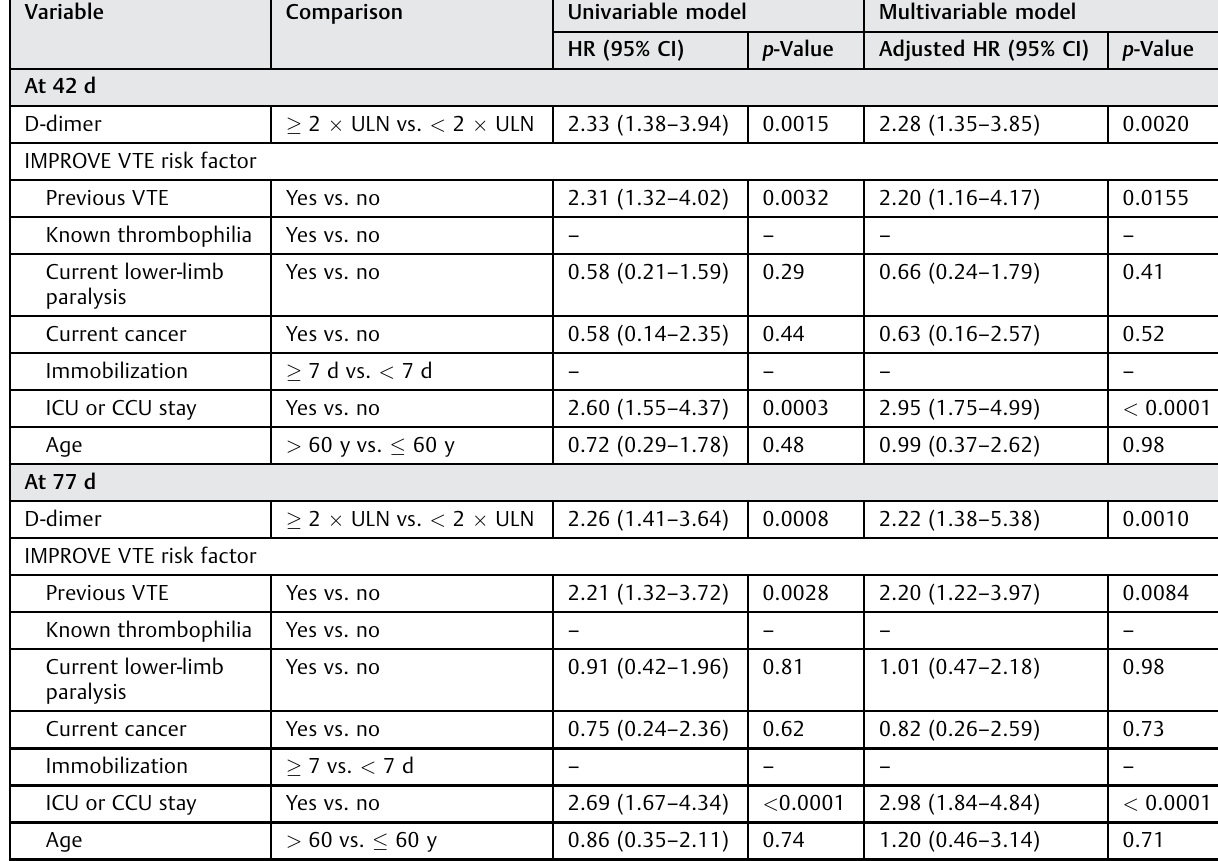
Table 2 Univariable and multivariable regression analysis of VTE risk factors a